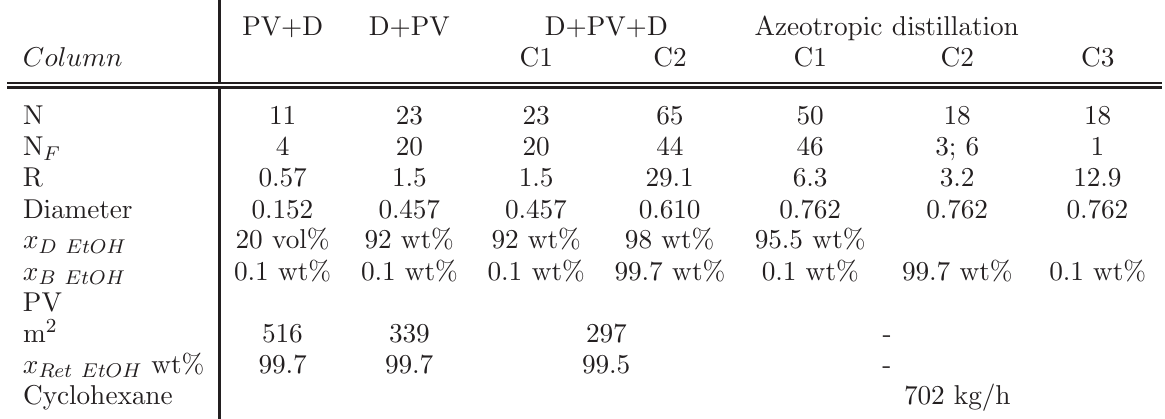
Table 10 Technological streams of adiabatic pervaporation,